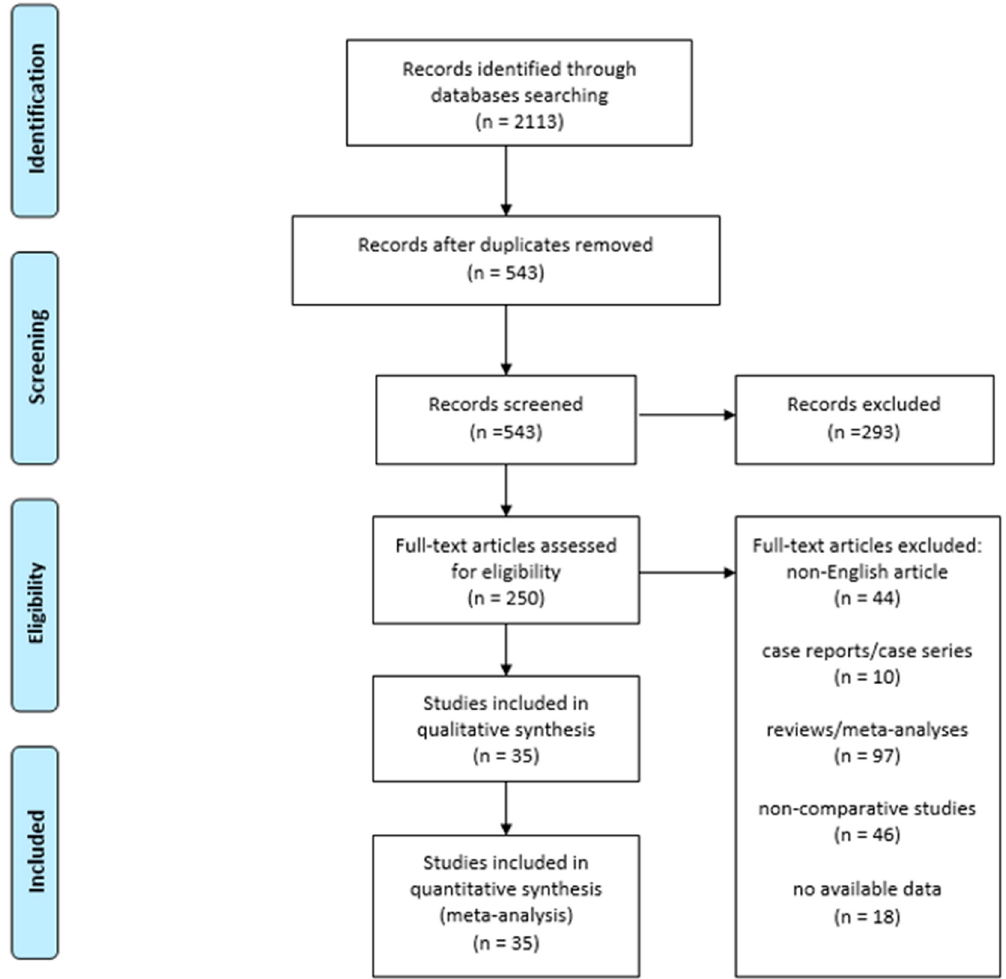
Figure 1. PRISMA Figure 1. PRISMA Flowchart.